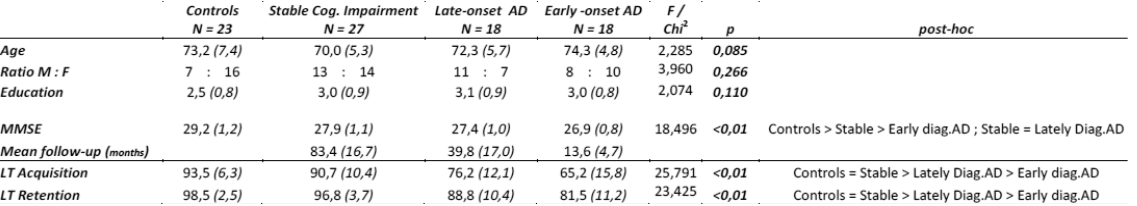
Table 1 Statistics for clinical & experimental variables. LT = Long-Term. Except for sex ratio, one-way analysis of variance were performed.